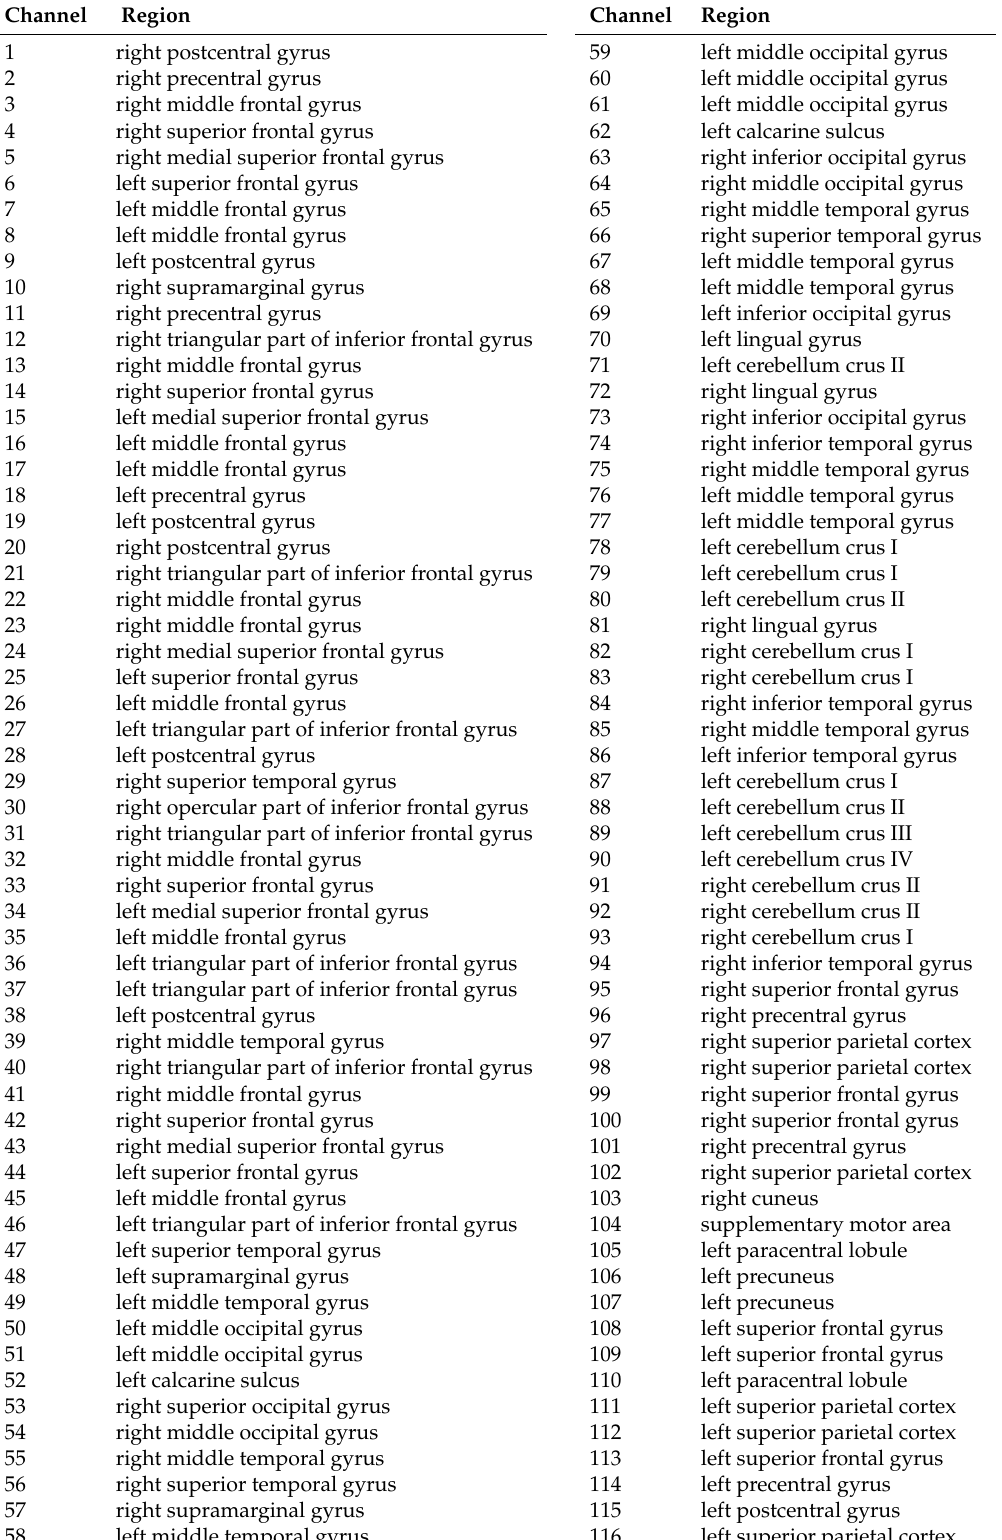
Table 1. The associated brain region corresponding to all the channels (116 channels). Each measurement channel was associated with the highest percentage of the brain regions for each